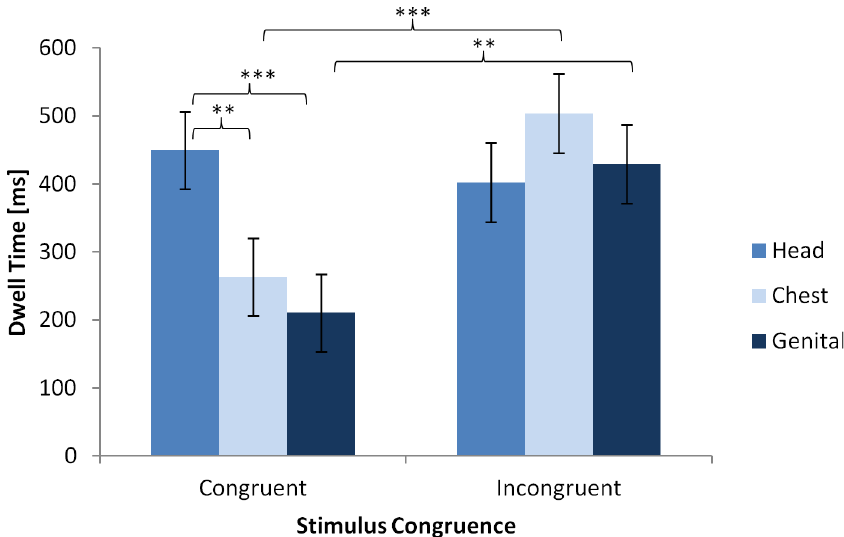
Fig 3. Means and SDs of dwell times [ms] as a function of stimulus congruence and area of interest [ms]. (cid:3)(cid:3) p < .01, (cid:3)(cid:3)(cid:3) p < .001.